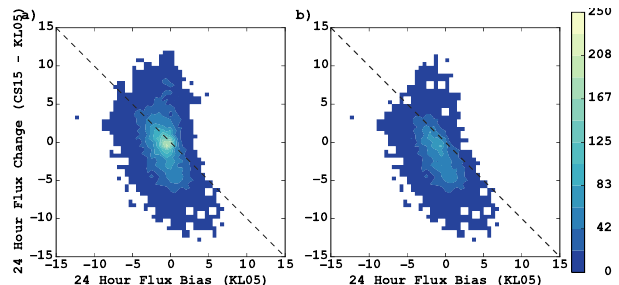
Figure 11. (a) Density plot between the grid box level (cid:49) ¯ F 24 ( y axis) and the 24h flux bias (from KL05 ADMs) for the months October–March for the years 2000–2004 for all valid grid boxes over Antarctica. (b) as in (a) with the grid boxes only limited to the eastern portion (0–180 ◦ E) of